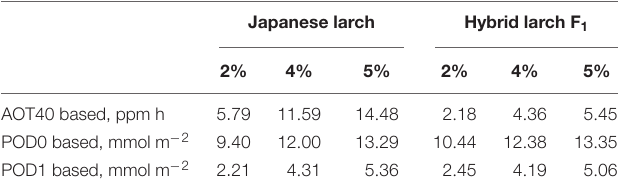
TABLE 3 | Critical levels for larch protection from ozone corresponding to a total biomass loss of 2%, 4%, or 5% and based on the dose–response relationships in Figure 2 . Japanese